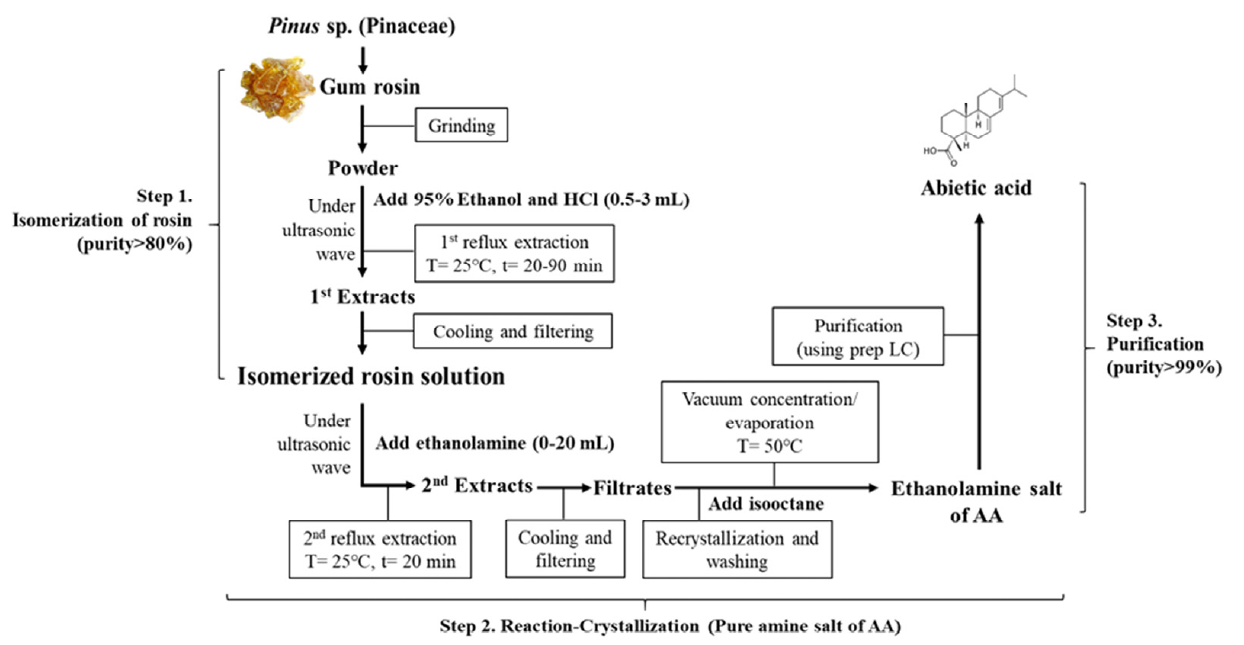
Figure 13. Experimental scheme for isolation, crystallization and purification of AA from rosin.